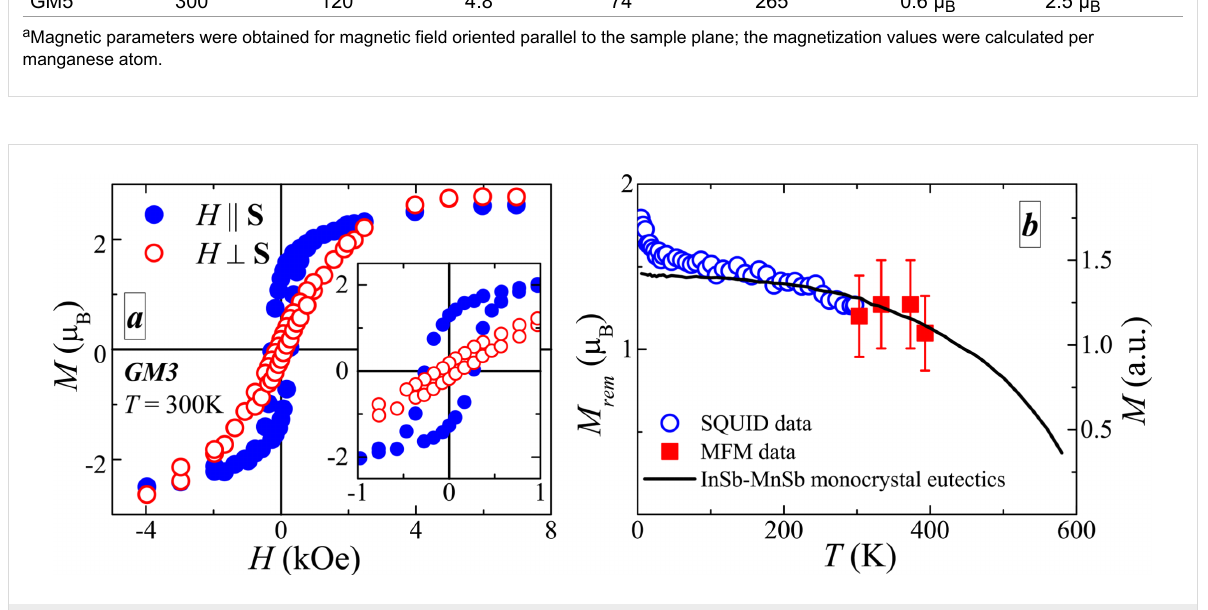
Figure 1: (a) Magnetization as a function of the magnetic field for sample GM3 at T = 300 K. Measurements were performed with the magnetic field oriented parallel to the sample plane (solid symbols) and perpendicularly to it (open symbols). The inset shows the hysteresis loop at low fields. (b) Temperature dependence of the remanent magnetization. Open circles are SQUID data for sample GM3, red squares are MFM data for the same sample and the black curve shows the temperature dependence of the saturation magnetization of the InSb–MnSb eutectic